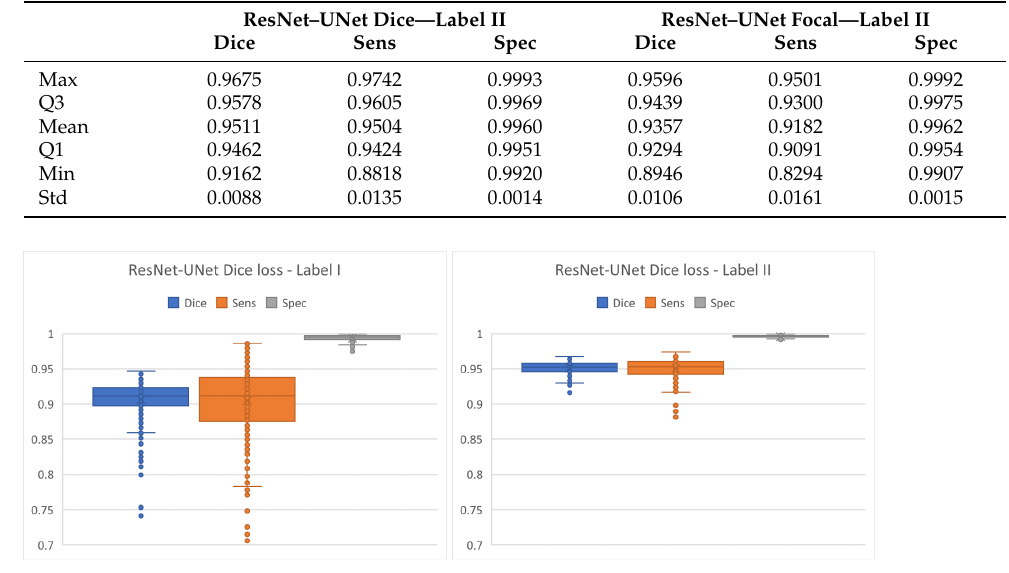
Figure 23. Improvement in labels in the two phases on the test set for Dice